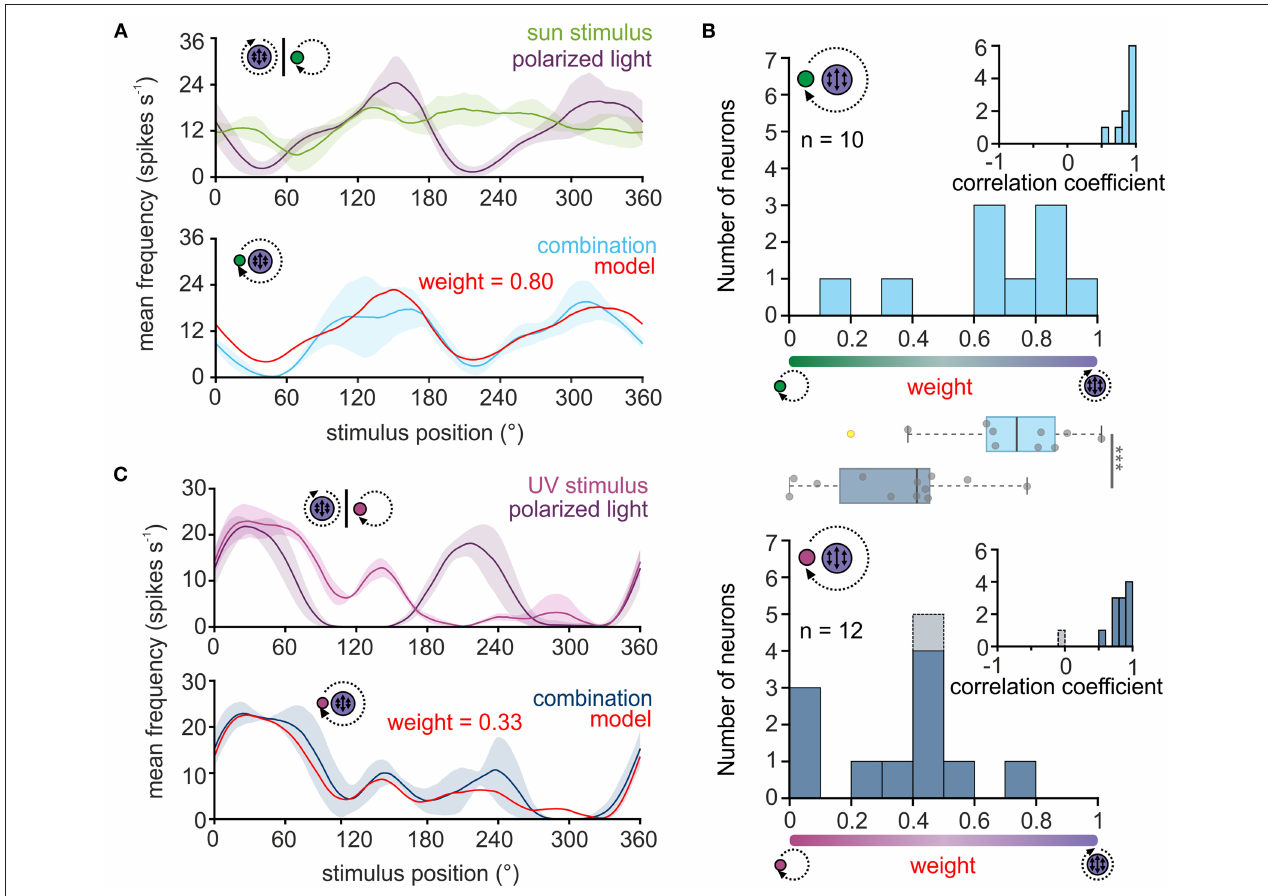
FIGURE 2 | Weighting of celestial cues in TL neurons. (A,C) Upper plot: sliding window averages of the action potential rates of two TL neurons to the green sun stimulus [ (A) , green curve] or UV light spot [ (C) , magenta] as well as to the polarization stimulus [ (A,C) , violet curves] are shown. Lower plot: The response of the same neurons as shown in the corresponding upper plots when both stimuli were presented simultaneously [ (A) , light blue; (C) dark blue curve]. Based on the response to the single cues, a weighted linear model was fitted to the data (red curve) and a weighting of the single cues was calculated. A weight between 0 and 0.5 suggests that the sun stimulus (A) or the UV light spot (C) dominated the combined response while a weight between 0.5 and 1 indicates that the polarization input dominates the combined response. The shaded areas show the standard deviation. (B) Histograms of the weighting factors obtained for the experiments with the green sun stimulus and polarized light (top, n = 10) and the UV light spot and polarized light (bottom, n = 12). Insets show the correlation coefficients which describe how well the weighted linear model explains the measured neural response to the combined stimulus. The weighting factor that was obtained from a low correlation coefficient is shown in gray. Box plots in the middle: While the weighting is shifted to the polarization input when a green sun stimulus was combined with polarized light, the weighting is significantly shifted in favor of the light spot, when a UV light cue was combined with polarized light ( p < 0.001, F = 113.31; linear mixed model ANOVA). Gray circles show individual data points (yellow circles indicate outliers). Boxes indicate interquartile range. Whiskers extend to the 2.5 th and 97.5 th percentiles. Black horizontal lines show the median. *** p <